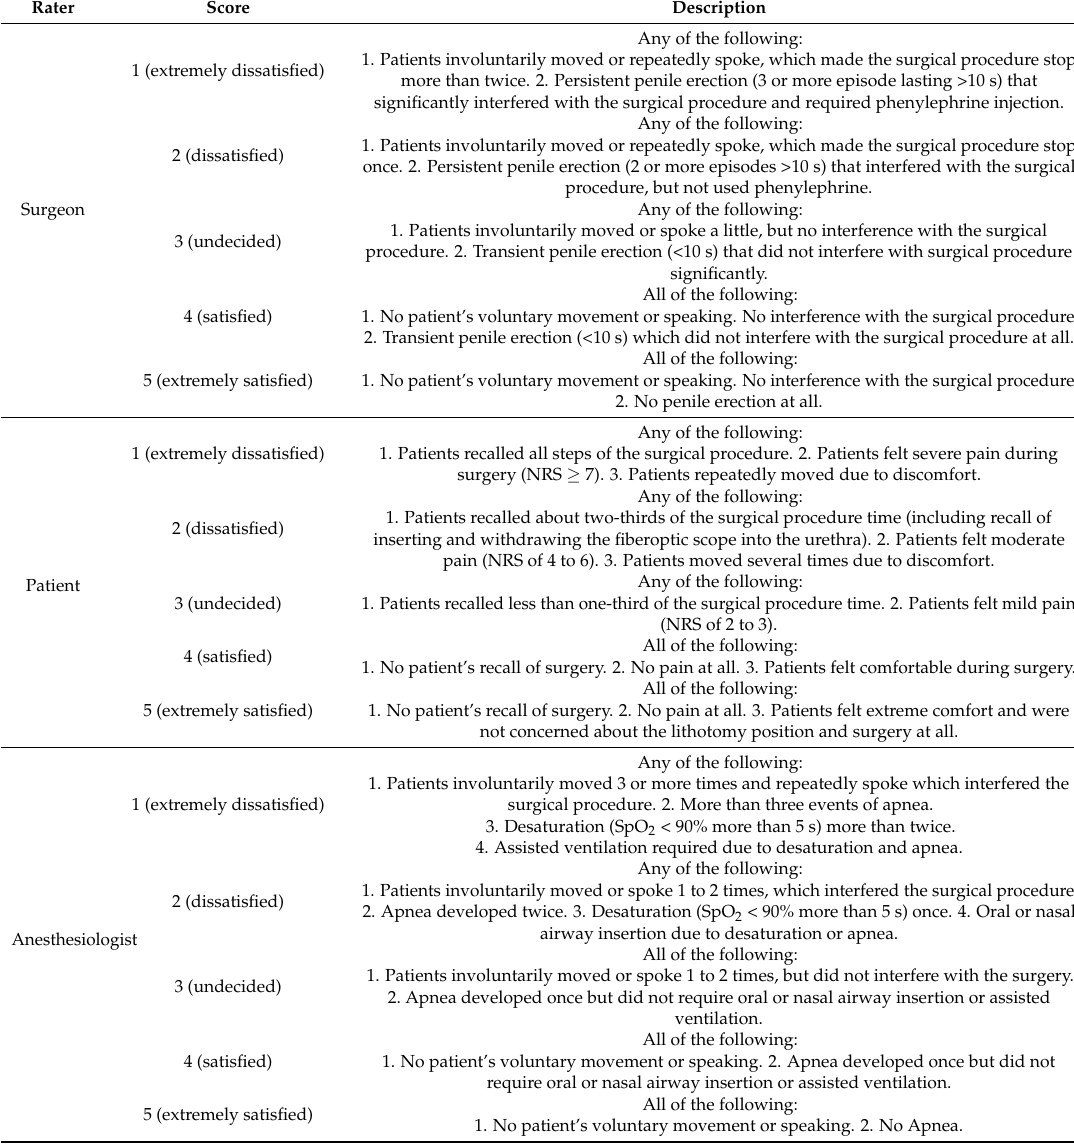
Table 1. Satisfaction